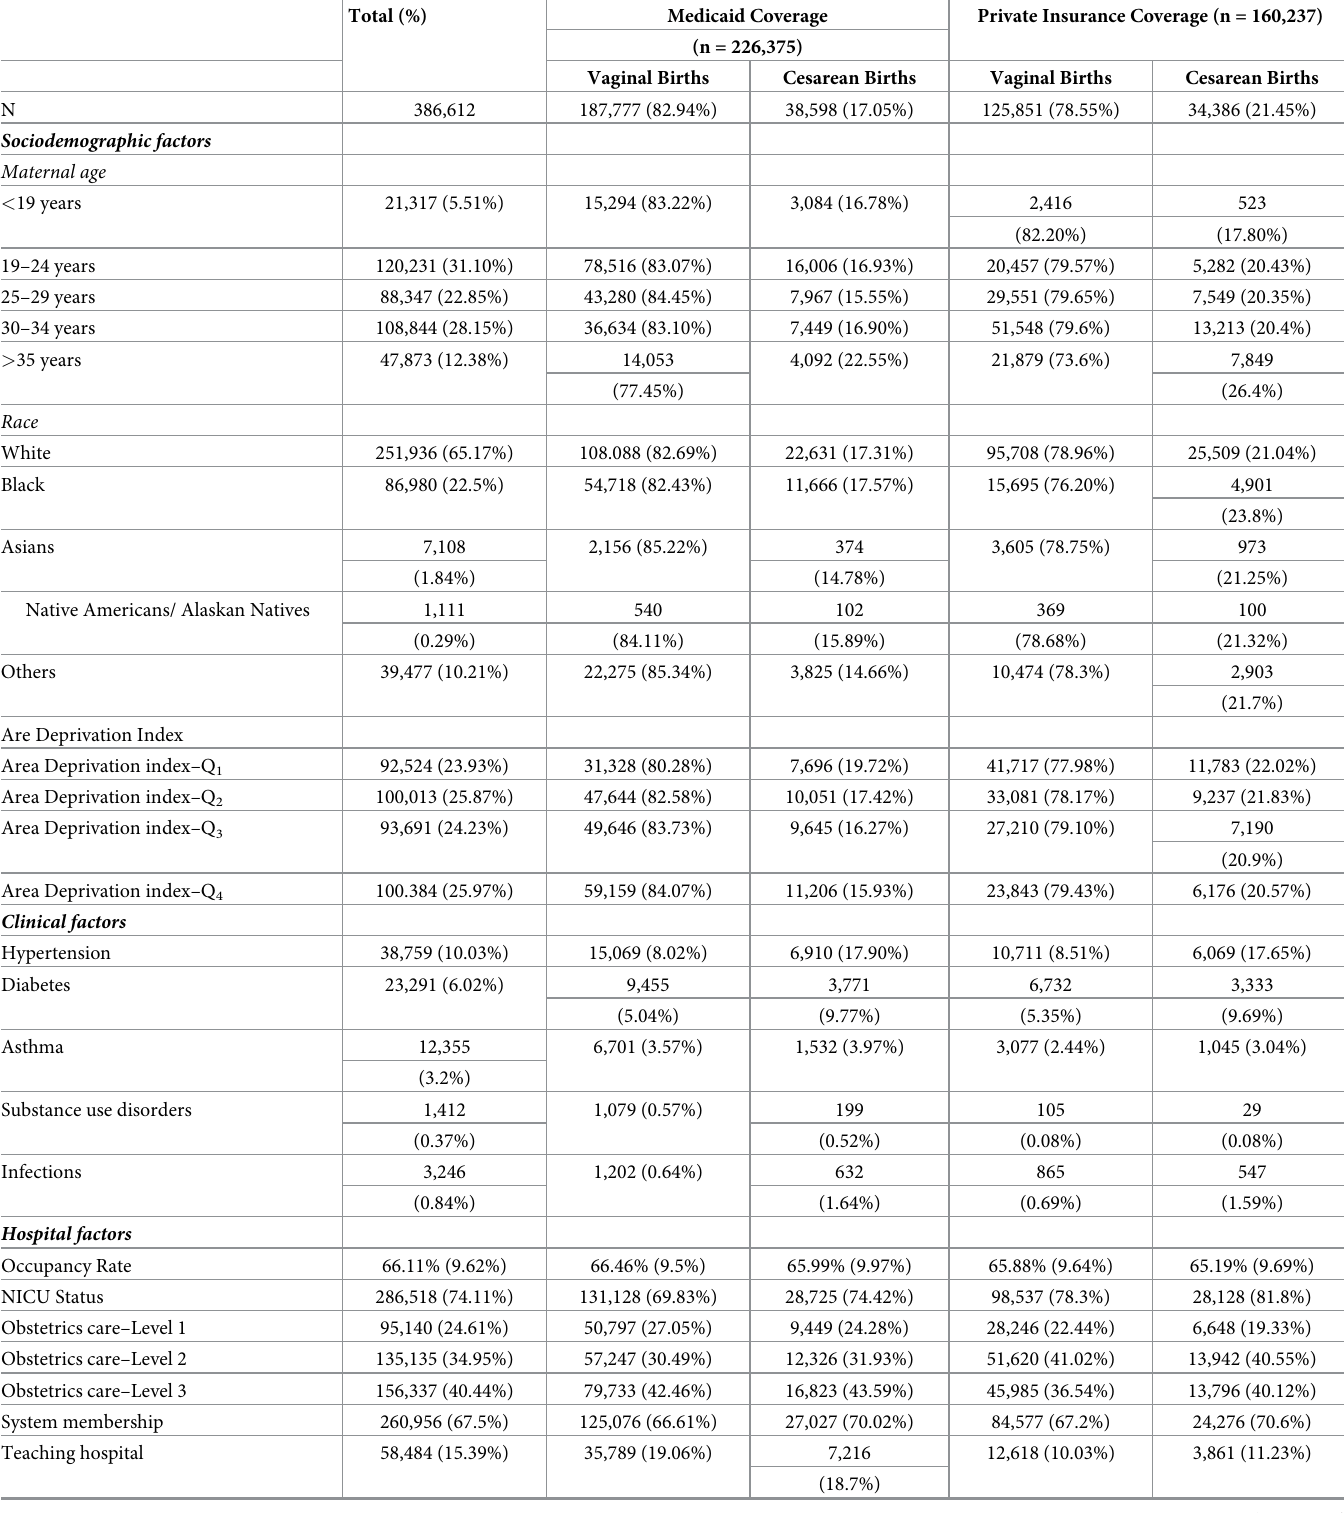
Table 1. Descriptive